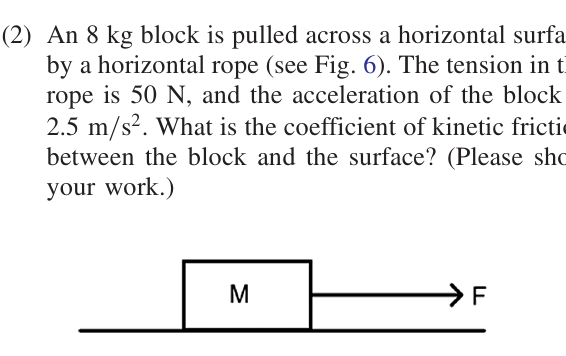
FIG. 6. Figure for friction post-test problem